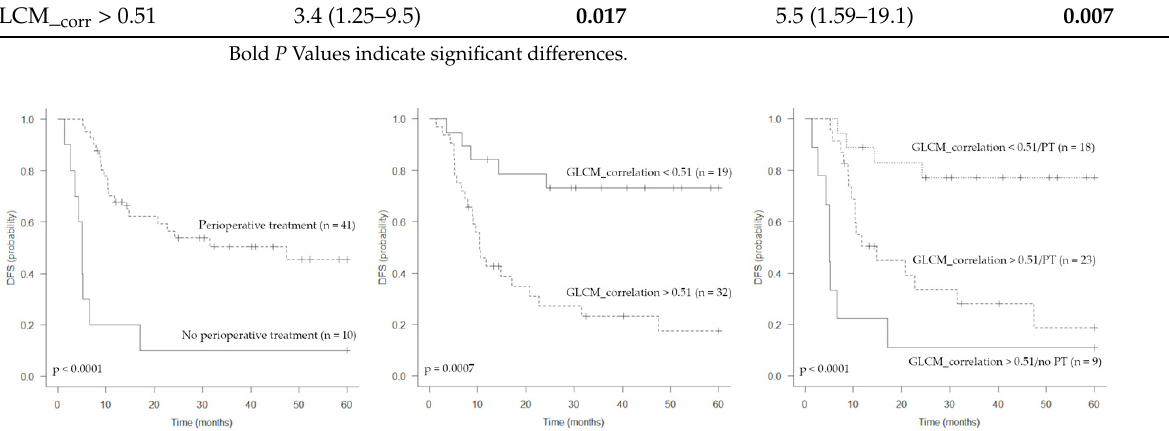
Table 3. Univariate and multivariate Cox proportional-hazards regression for the prediction of DFS and OS.